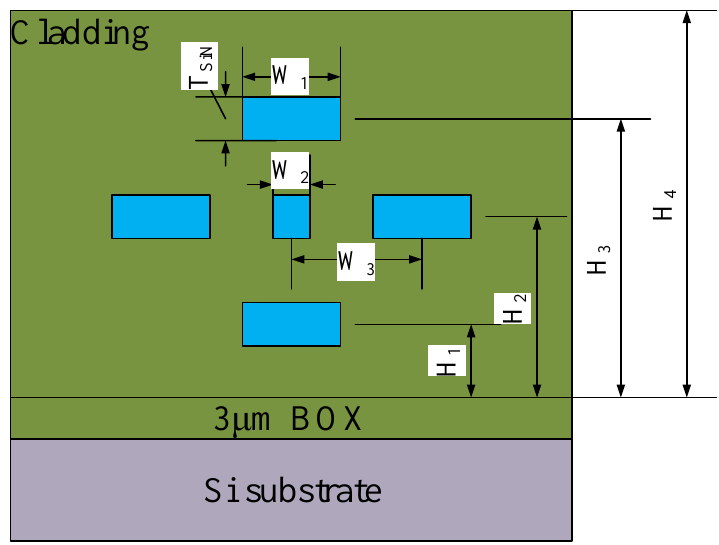
Figure 1. Schematic of the designed edge coupler.